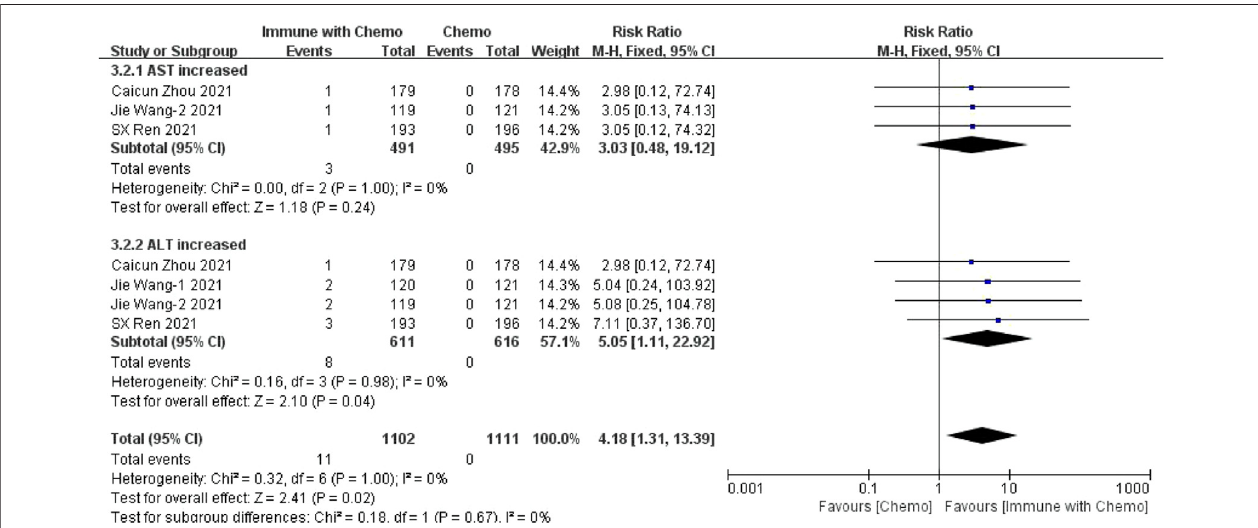
FIGURE 8 | Meta-analysis results of adverse reactions above grade 3 in hepatotoxicity between the Chemo with immune group and chemo group.